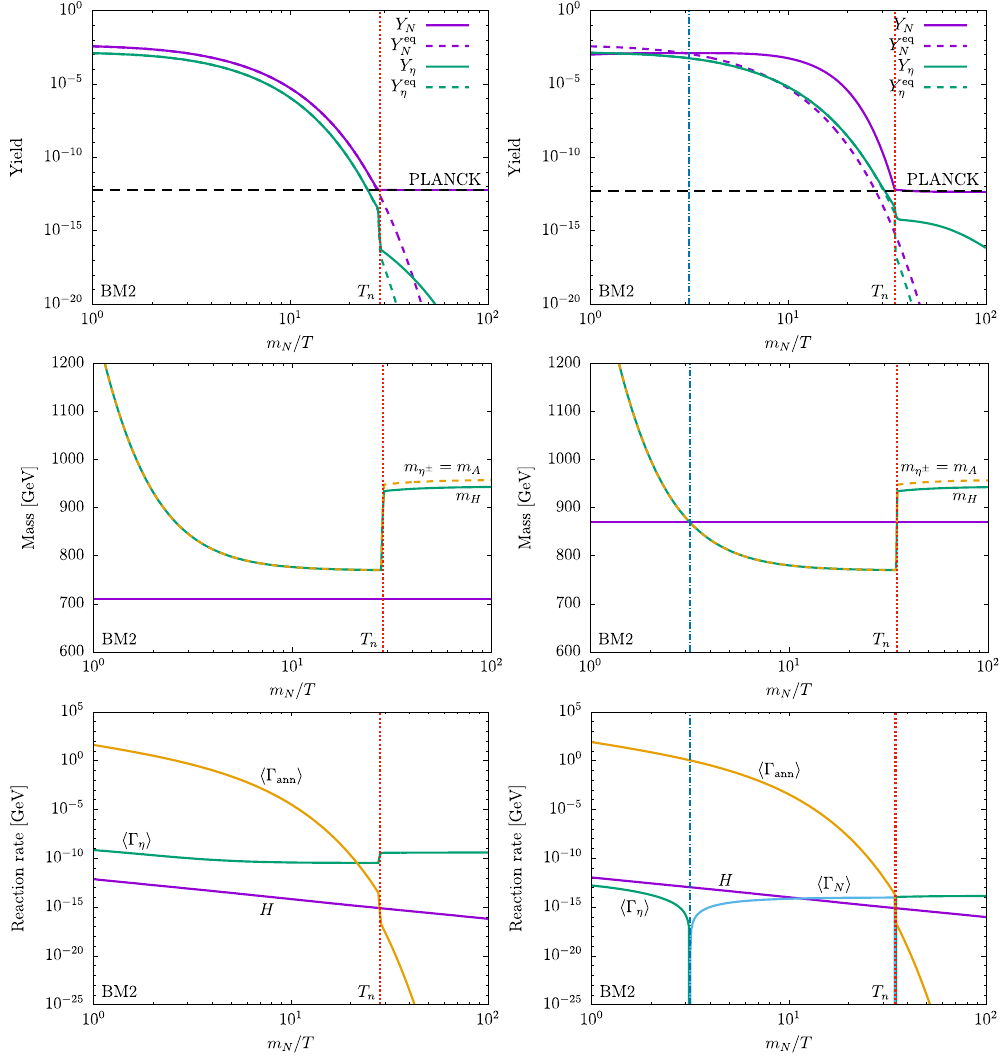
Figure 8 . Same plots with figure 7 for BM2 where the dark matter mass and the Yukawa coupling are fixed at ( m N , | Y | ) = (710 GeV , 1 . 00 × 10 − 5 ) for the left panels, and (870 GeV , 1 . 54 × 10 − 7 ) for the right panels,